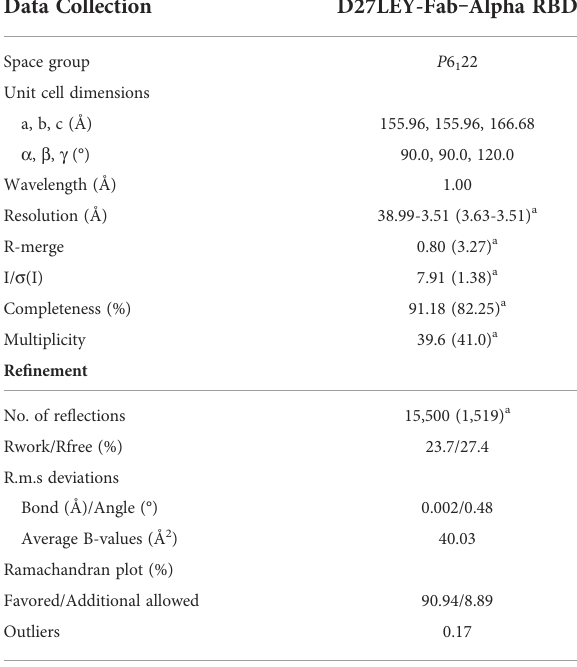
TABLE 1 X-ray data collection and structure re fi nement